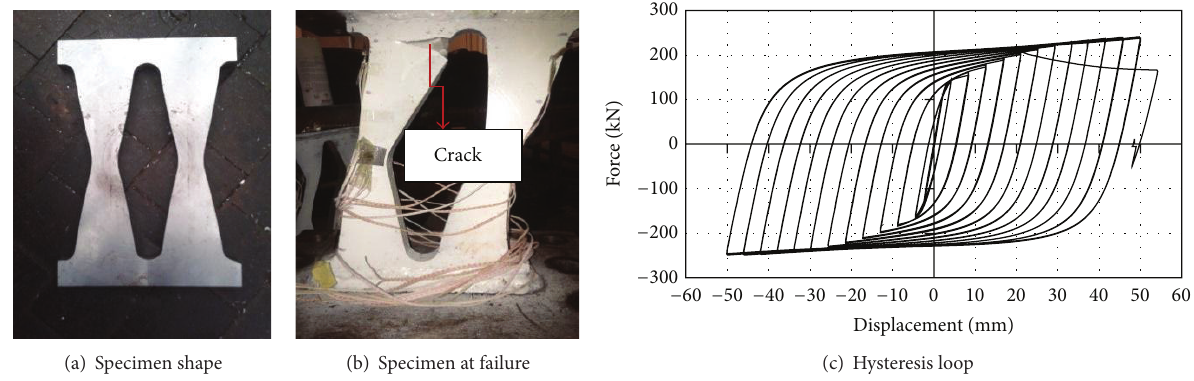
Figure 12: Results of specimen cyclic test for